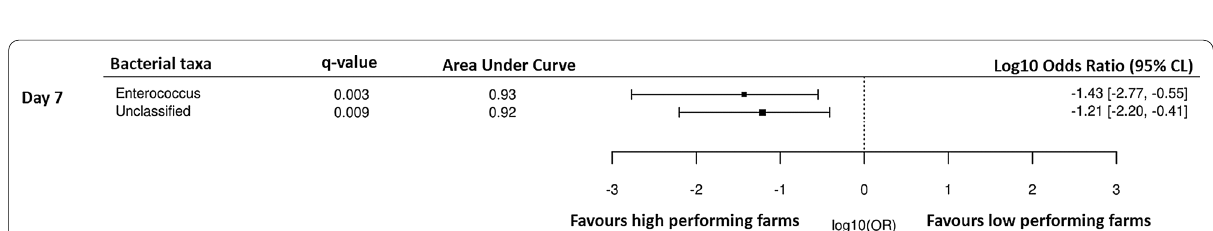
Fig. 8 Forest plot of the significantly different bacterial taxa (Wilcoxon q value < 0.05) of company A farms in excreta with AUC to the left of the vertical line (line of no effect) denotes the increased chance of occurrence of microbiota towards high‑performing farm and the results to the right of the vertical dotted lines denotes the increased chance of occurrence of microbiota towards the low‑performing farm